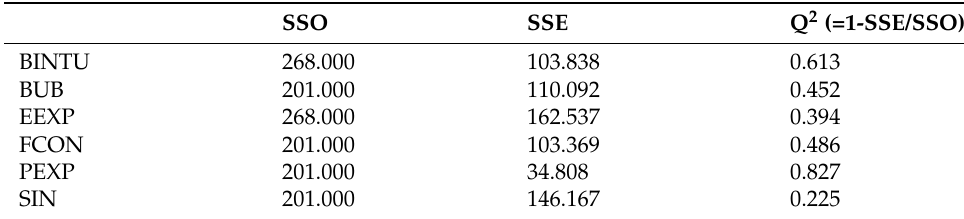
Table 10. Construct cross-validated communality.